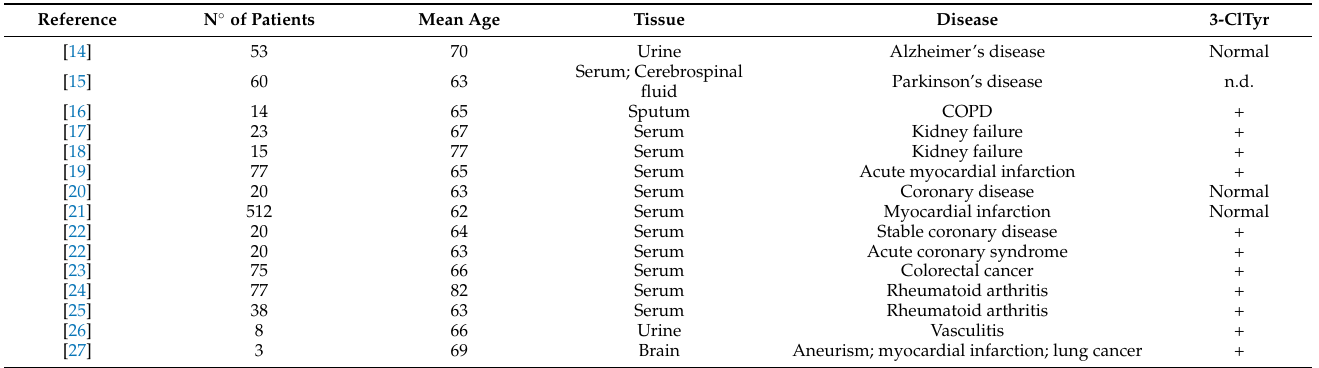
Table 1. A list of the research articles included in the review evaluating chlorinative stress in elderly